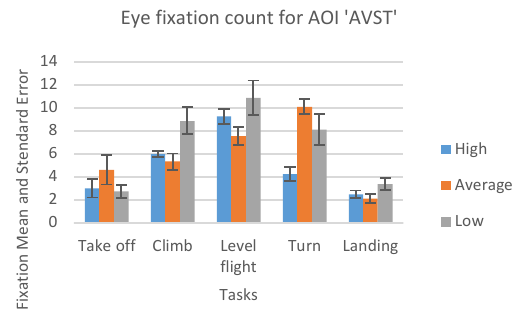
Figure 13. Number of eye fixations inside AOI ‘AST’ for five flight phases for the psychological selection stream with associated standard errors.